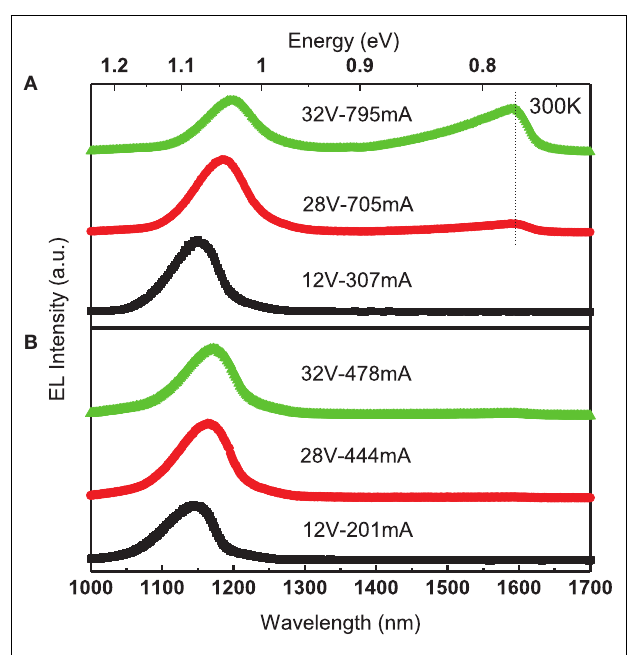
FIGURE 3 | Room-temperature EL spectra at different electrical currents of two pn diodes: (A) for sample B and (B) for sampleA